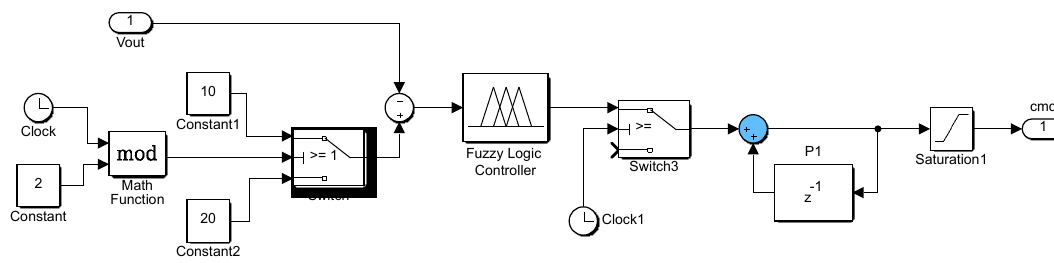
Figure 15. Circuit simulation model for the LDR.